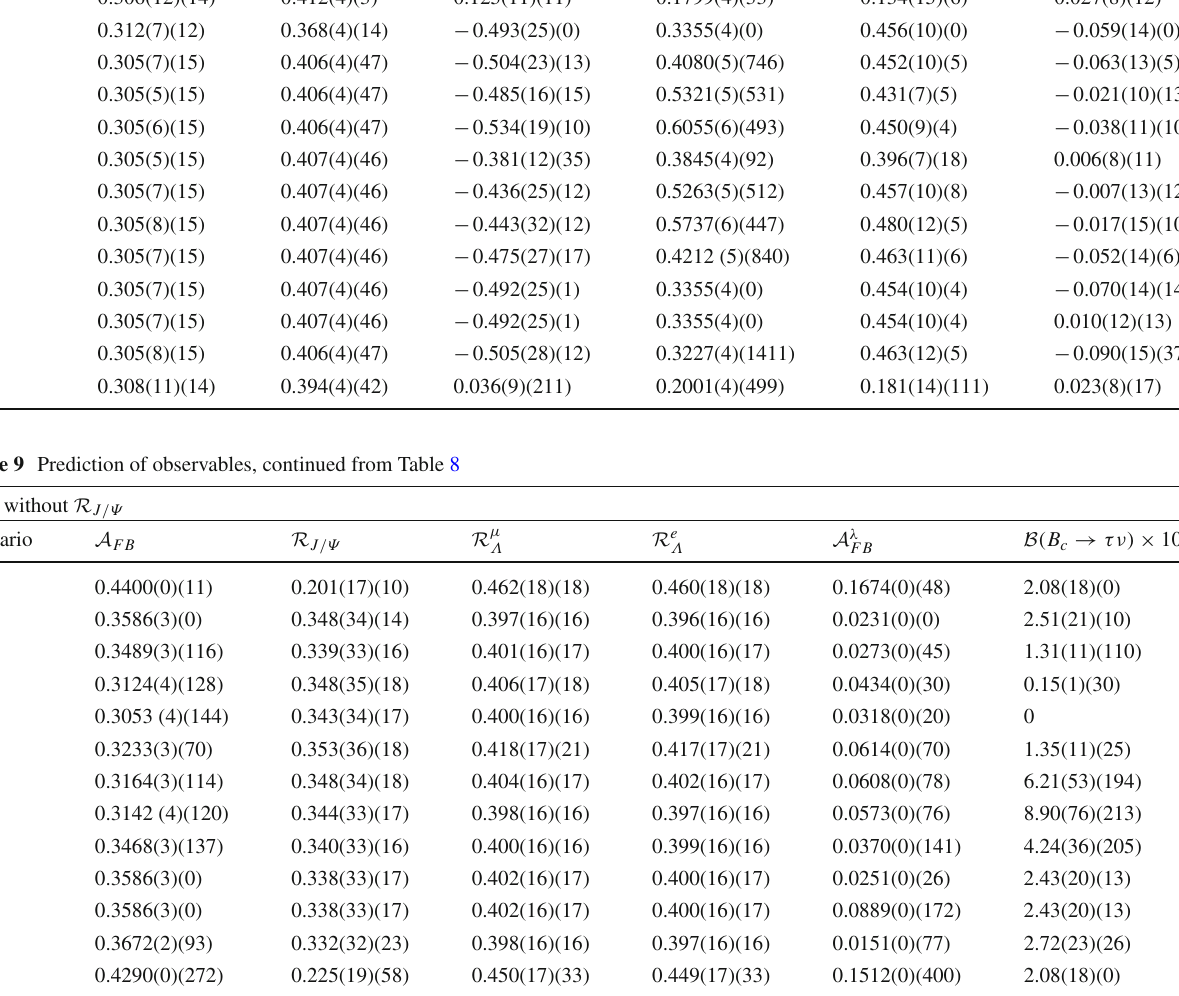
andthesecondoneforuncertaintiesofthefittedNPWilsoncoefficients. Though inmostcasestheNP error ispredominant compared totheform factor ones, we quote both of them. These results continue in Table 9